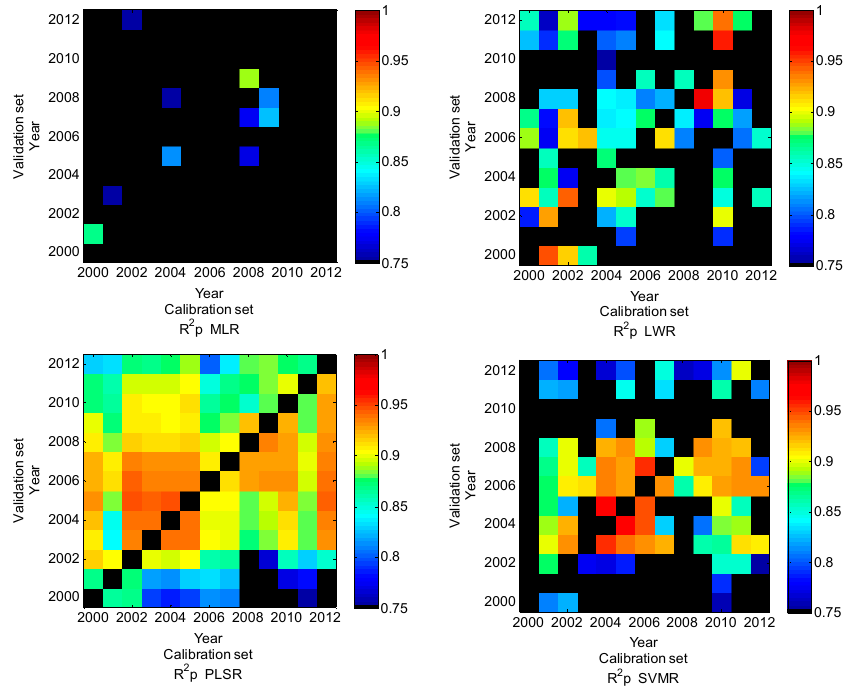
Figure 4 . (cid:1844) (cid:2870) (cid:1868) for different data mining methods in validation across years. Figure 4. R 2 p for different data mining methods in validation across